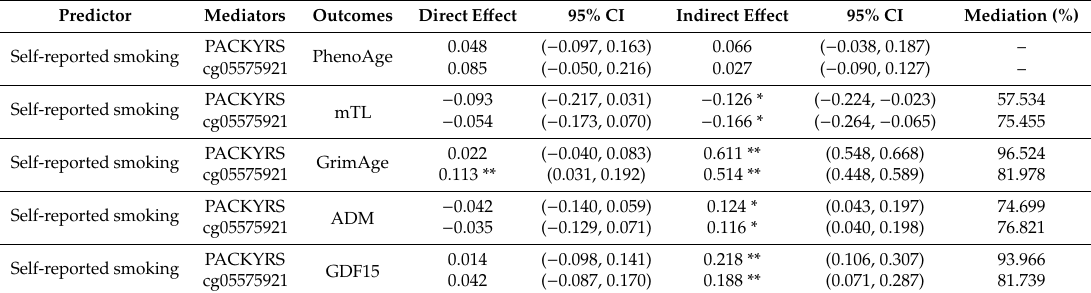
* p ≤ 0.05; ** p ≤ 0.01 (two-tailed tests). Note : the measure of accelerated aging using the residual scores from the regression of DNA methylation-based age on chronological age; BMI, gender, and cell-types (Monocytes, natural killer, CD8 + T, CD4 + T, and Bcells) were controlled; PACKYRS = DNAm-based estimate of smoking pack-years; mTL = DNA methylation-based telomere length; GrimAge = DNA methylation-based biomarker of mortality risk age; ADM = adrenomedullin; GDF15 = growth di ff erentiation factor 15. Table 4. Test of direct and indirect e ff ects of self-reported cigarette consumption (past 8 years) on epigenetic aging through DNA methylation-based estimate of smoking pack-years and cg05575921 controlling for age; BMI, and gender but not cell-type composition (N = 500). Predictor